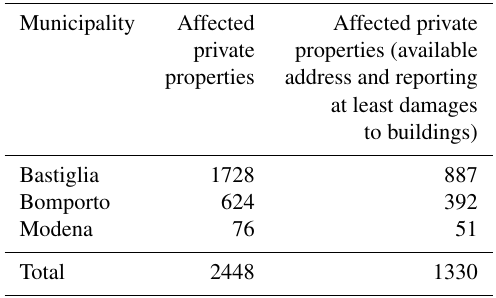
Table 1. Number of forms filled by private owners per